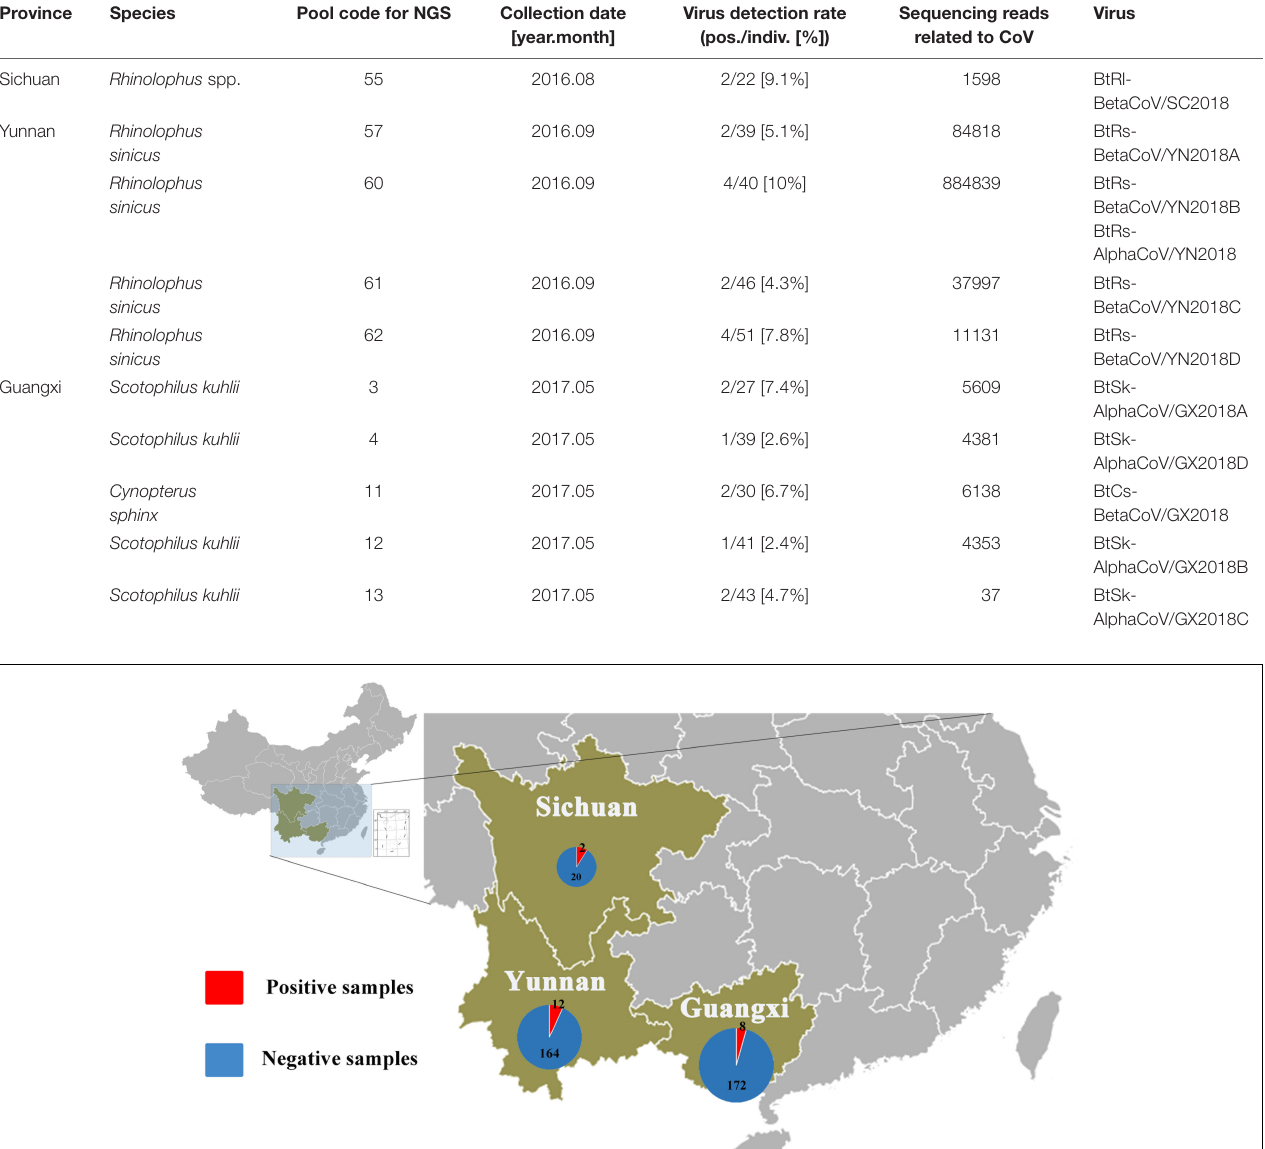
TABLE 1 | Coronavirus distribution in different bat species and locations.